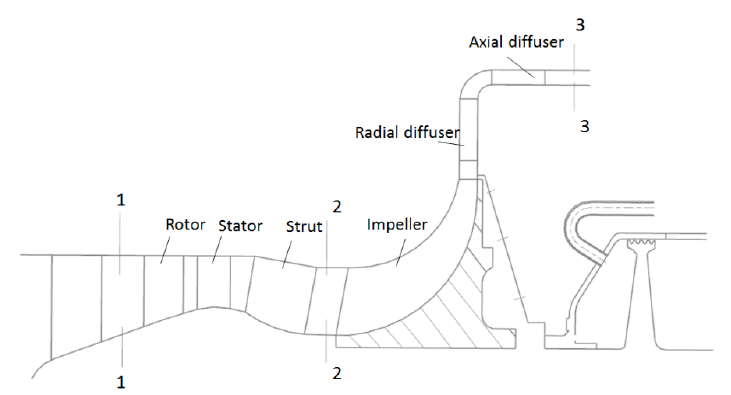
Figure 20. Schematic of the combined compressor test part.